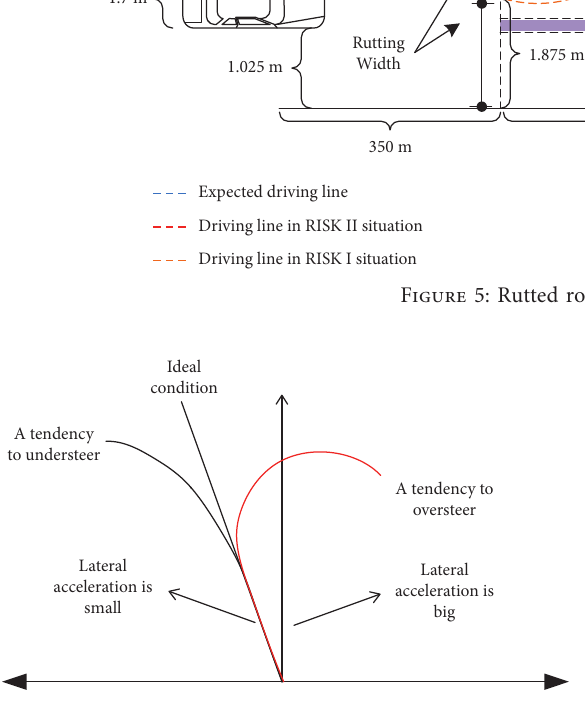
Figure 6: Vehicle’s instability